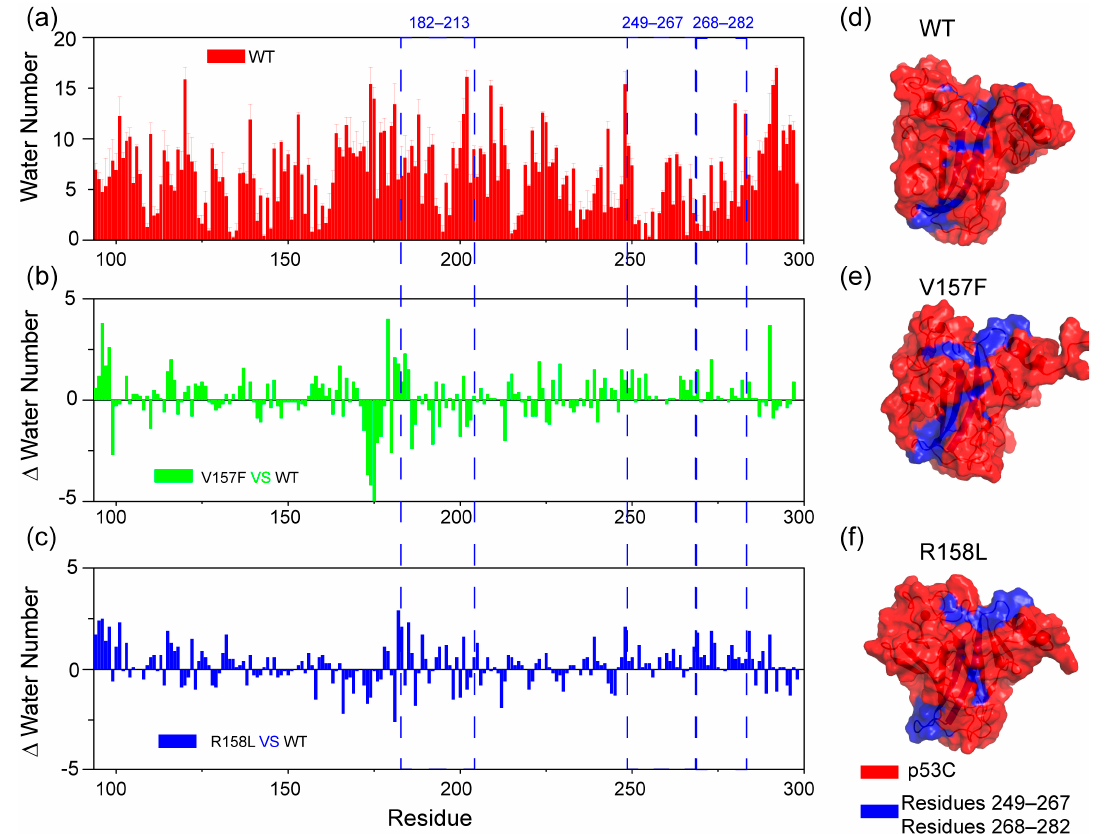
Figure 2. The extent of solvation of p53 C in WT, V157F and R158L systems. ( a ) The number of water molecules within 0.35 nm of WT p53C. The three aggregation core fragments (residues 182–213, 249–267 and 268–282) are pointed out by blue dotted line. ( b , c ) The difference value of water number between V157F/R158L mutant and WT p53C. ( d – f ) Snapshots of exposure for residues 249–267 and 268–282 in WT, V157F and R158L systems. Residues 249–267 and 268–282 are colored blue.